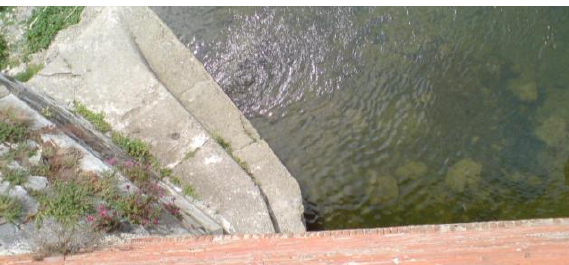
Figure 2 – View from the top of the bridge of the